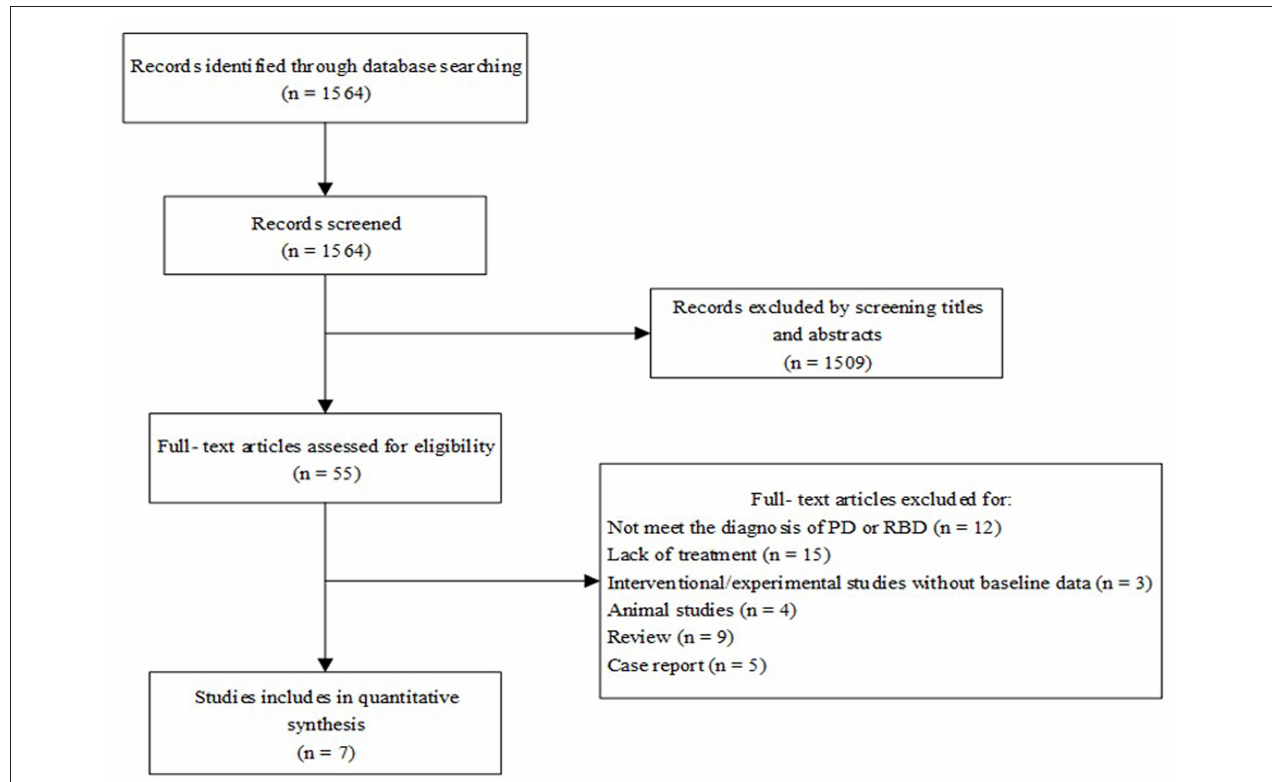
FIGURE 1 | The PRISMA flow